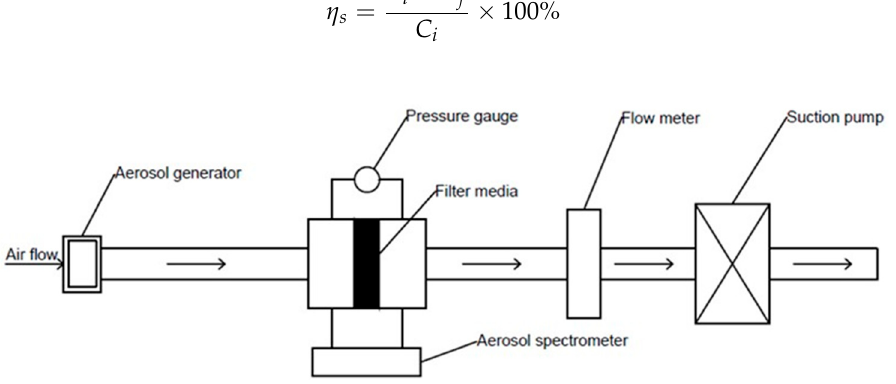
Figure 2. An experimental device was used to determine the static filtration performance of a filter media.